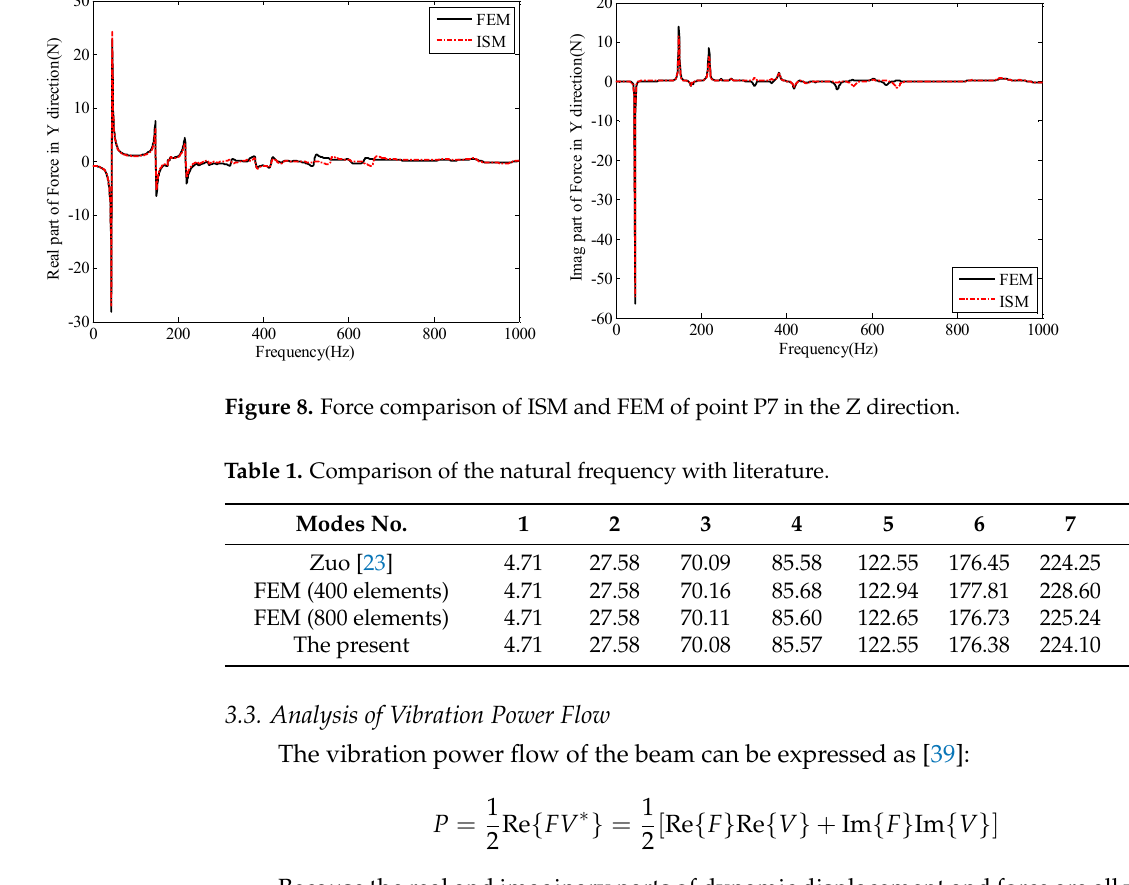
Figure 7. Dynamic responses of point P2 compared with FEM: ( A ) in z direction, ( B ) in y direction.